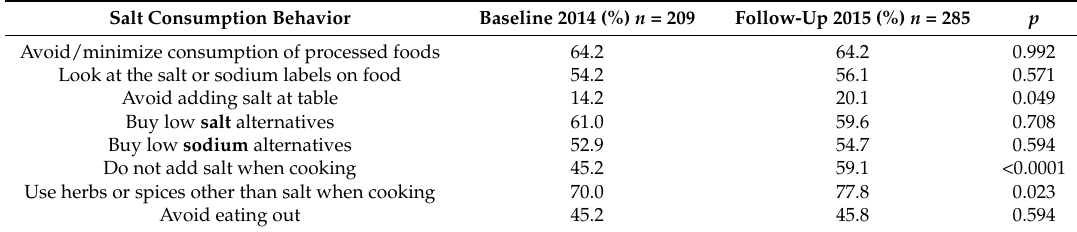
Table 5. Percentage of respondents before and after the intervention who reported changing their salt consumption behavior on direct